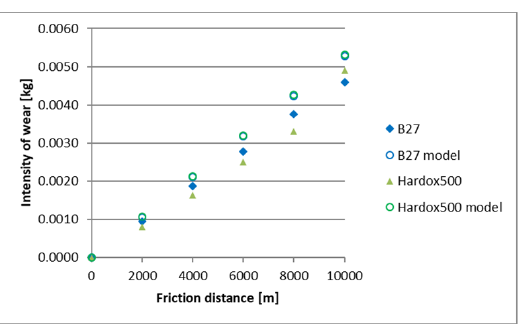
Figure 11. The course of theoretical and empirical wear of B27 and Hardox 500 steels in medium soil.